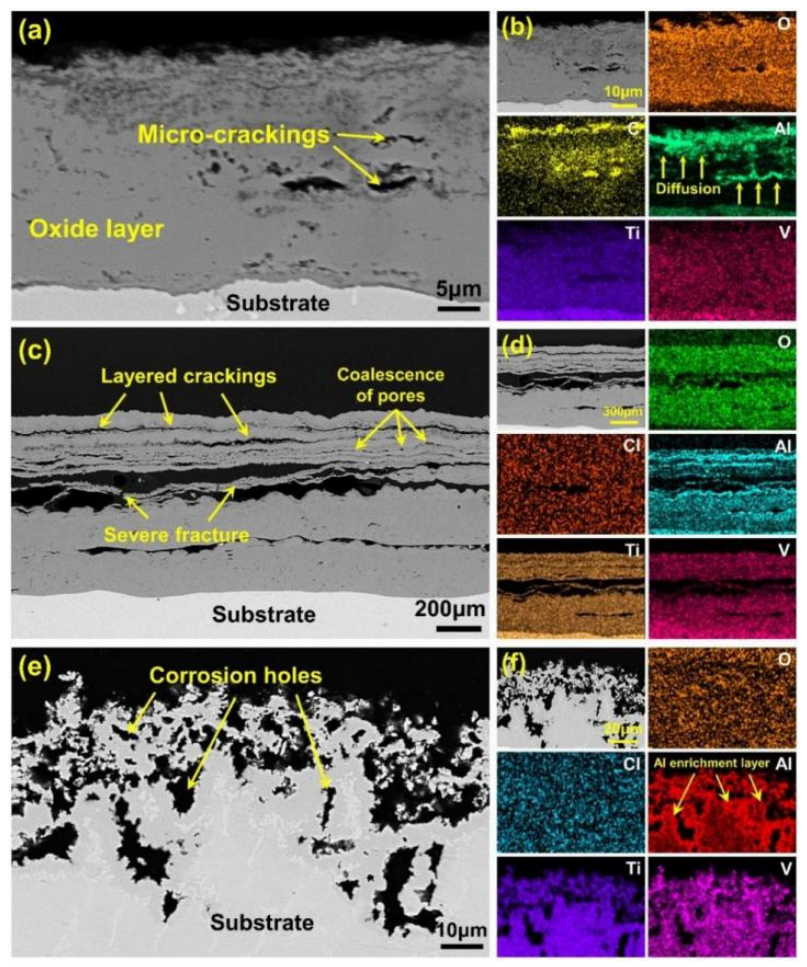
Figure 8. Cross-sectional SEM images and element mappings of the tested samples: ( a ) and ( b ) H2; ( c ) and ( d ) H3; and ( e ) and ( f ) H4.